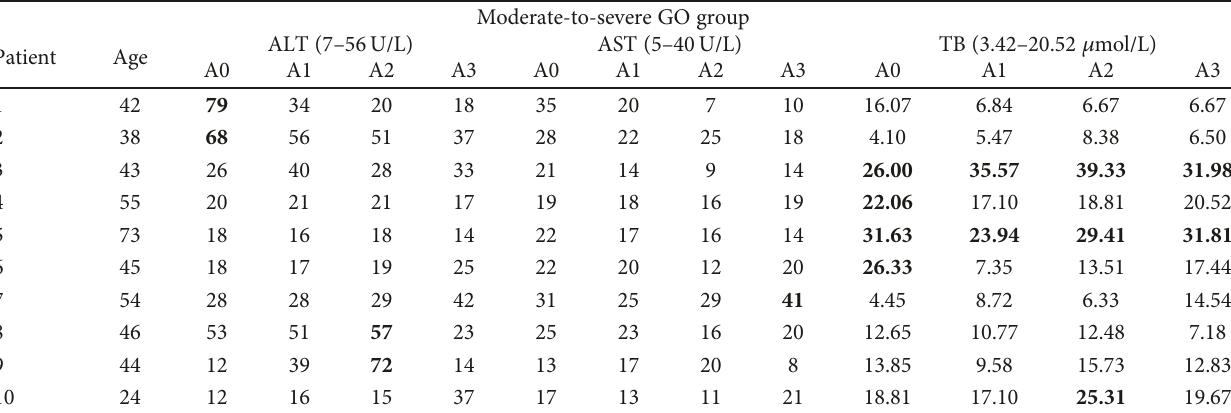
Table 2: Range of parameters in the moderate-to-severe GO group with increased aminotransferases (values above the upper limit of normal are shown